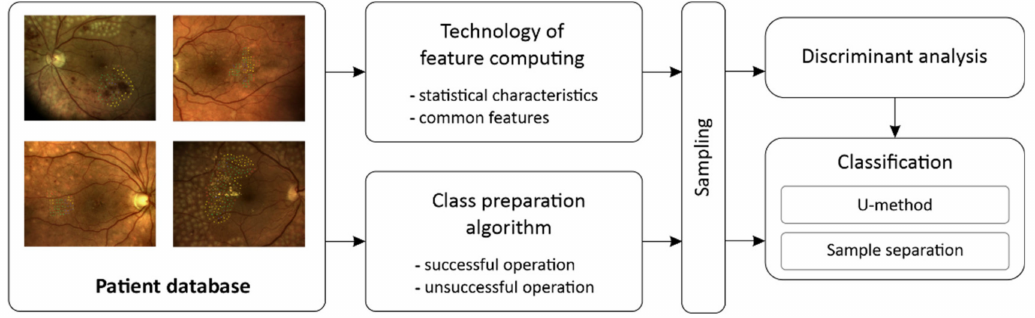
Figure 5. The technology for intelligent analysis of the preliminary photocoagulation